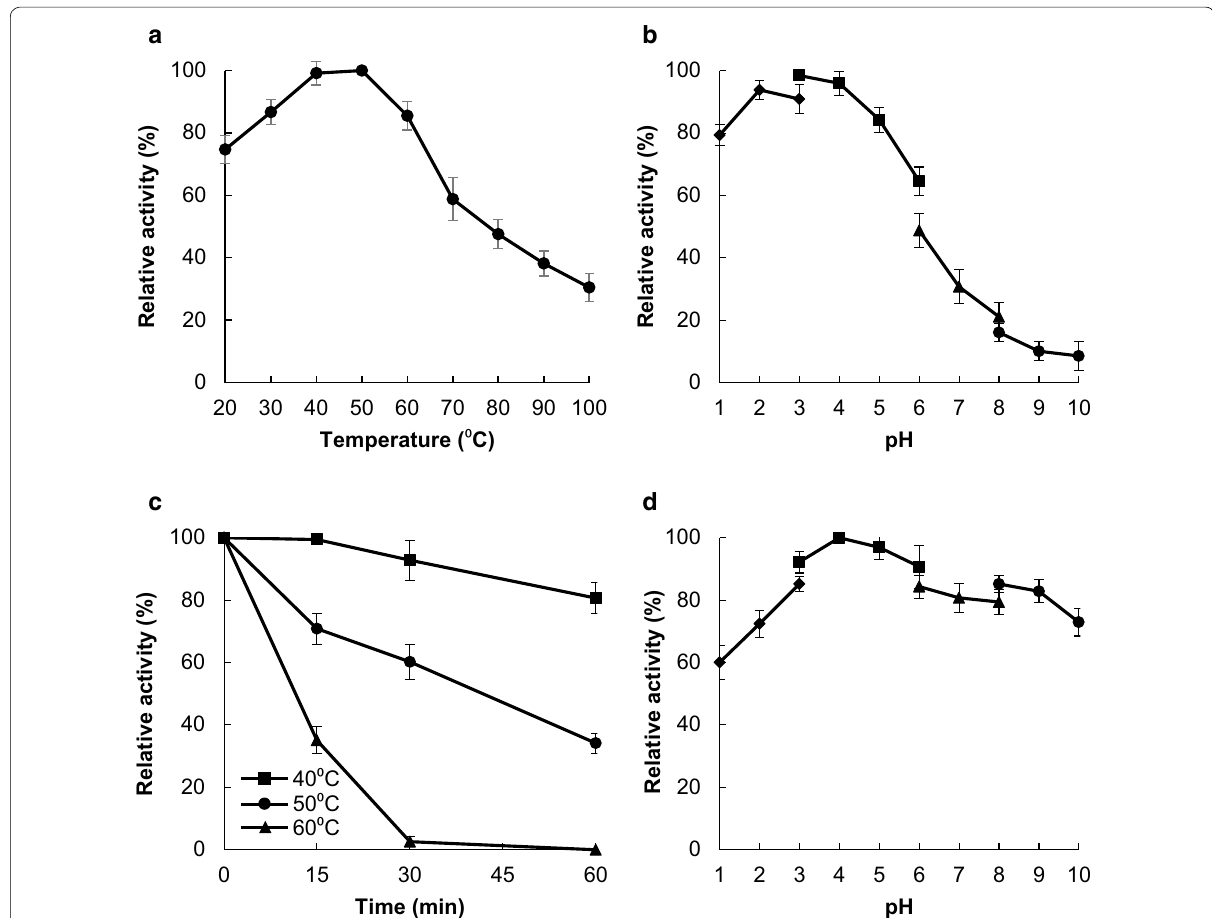
Fig. 5 Biochemical characterization of FsXEG12A. a Optimal temperature of FsXEG12A. Enzyme reactions proceeded at temperatures ranging from 20 to 100 °C for 60 min. b Optimal pH of FsXEG12A. Enzyme reactions proceeded over a pH range of 1.0–10.0 in 50 mM glycine–HCl (pH 1.0–3.0, filled diamond), 50 mM sodium acetate (pH 3.0–6.0, filled square), 50 mM sodium phosphate (pH 6.0–8.0, filled triangle), and 50 mM Tris–HCl (pH 8.0–10.0, filled circle). c Thermostability of FsXEG12A. Purified FsXEG12A was incubated from 40 to 60 °C for 60 min, and then residual activity against 1.0% CMC was measured after further incubation at 50 °C for 60 min at the optimal pH (pH 3.0). d pH-stability of FsXEG12A. Purified FsXEG12A was incubated in 50 mM glycine–HCl (pH 1.0–3.0, filled diamond), 50 mM sodium acetate (pH 3.0–6.0, filled square), 50 mM sodium